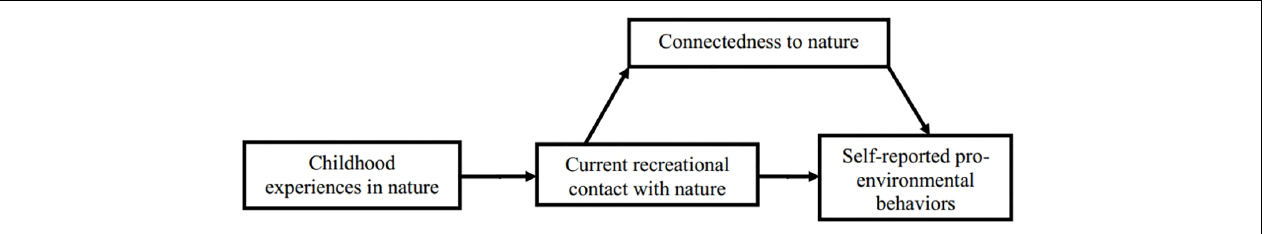
FIGURE 1 | Hypothesized relationships between constructs.